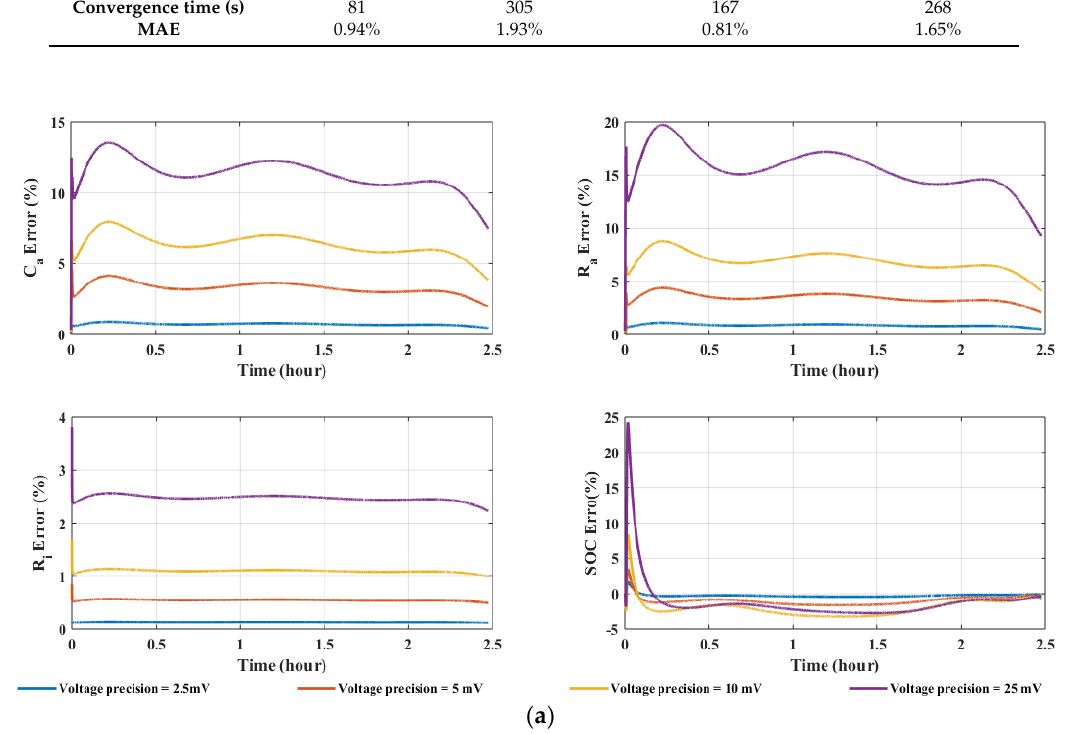
Figure 11. Cont Figure 11. Cont.